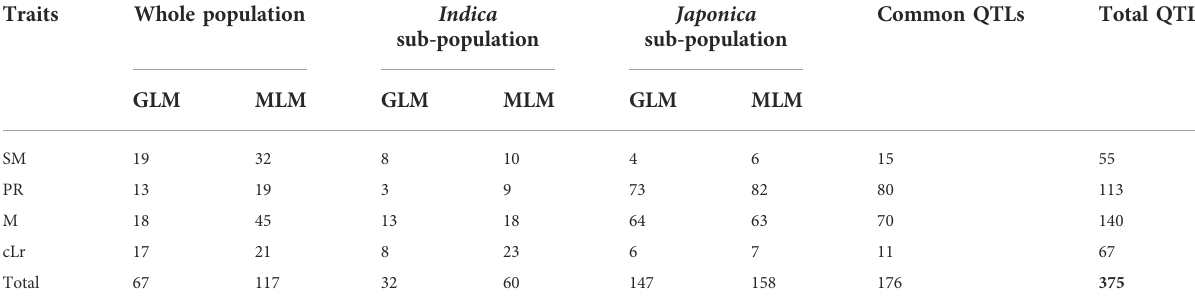
TABLE 4 Summary of QTLs identi fi ed for lodging resistance traits in three populations by different regression models.